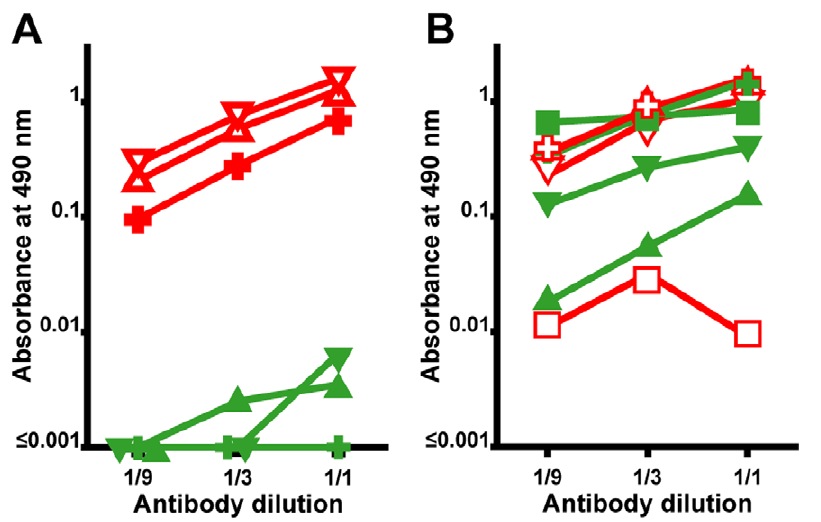
Figure 2. Relative reactivities of antibodies towards native and denatured SOD1. ELISA plates were coated with either native (filled symbols in green) or denatured (unfilled symbols in red) SOD1, and were either reacted with antibodies raised against peptides (A) or whole SOD1 (B). Threefold dilutions were made from a high antibody concentration giving an A 490 of 0.70–1.6 with either native or denatured SOD1. (A) Reactivity of the 4–20Ra-ab (native = m , denatured = n ), 57–72Ra-ab (native SOD1 = , denatured SOD1 = ‘‘ ) and 131–153Ra-ab (native SOD1 = . , denatured SOD1= , ) anti-SOD1 peptide antibodies. The highest concentrations were 0.1 m g/ml, 0.03 m g/ml, 0.1 m g/ml, respectively. (B) Reactivity of antibodies raised to whole SOD1: Rabbit-1 antibody (native SOD1 = , denatured SOD1 = ‘‘ ); a sheep antibody from Calbiochem (native = m , denatured = n ); a sheep antibody from The Binding Site (native SOD1 = . , denatured SOD1= , ); and a mouse monoclonal antibody from Sigma (native SOD1 = & , denatured SOD1 = ). The highest concentrations were 0.6, 10, 20, and 10 m g/ml, respectively. The data presented are means of 4 wells for each